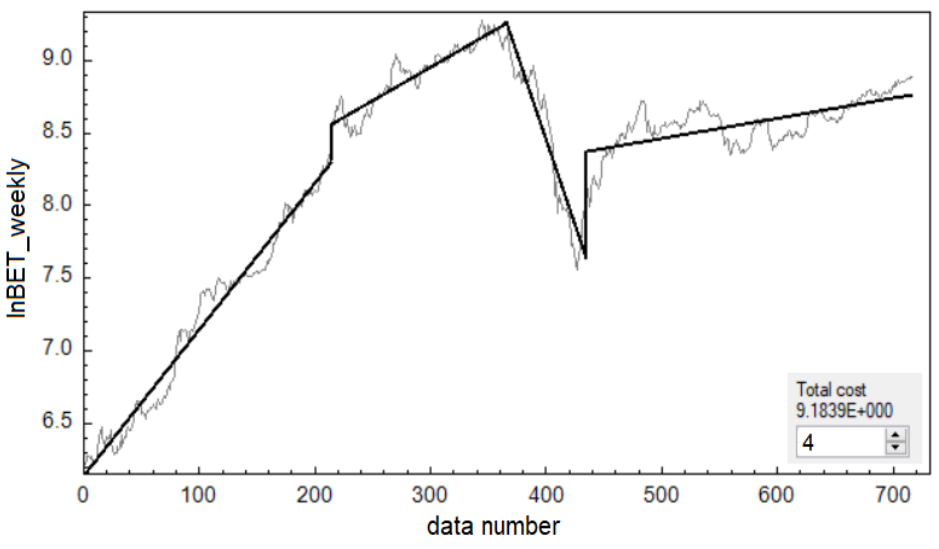
Figure 3. The best model for S4_ms (with lag 1 regressor).